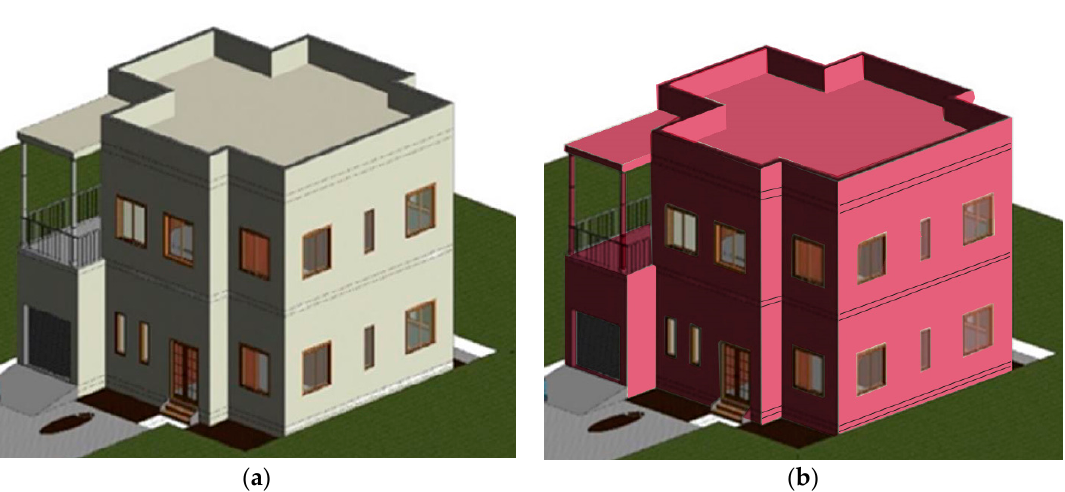
Figure 9. ( a ) Two story residential building with common coatings. ( b ) Two story residential building with low-brightness and high-reflective coatings. Table 3. Thermophysical parameters of the building used for